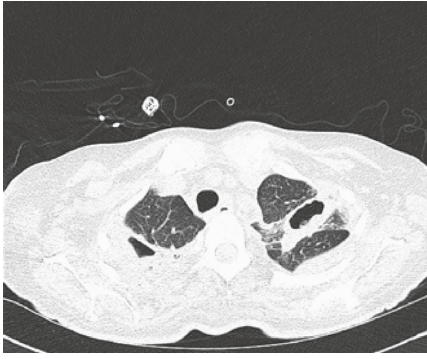
Figure 1: CT scan showing bilateral